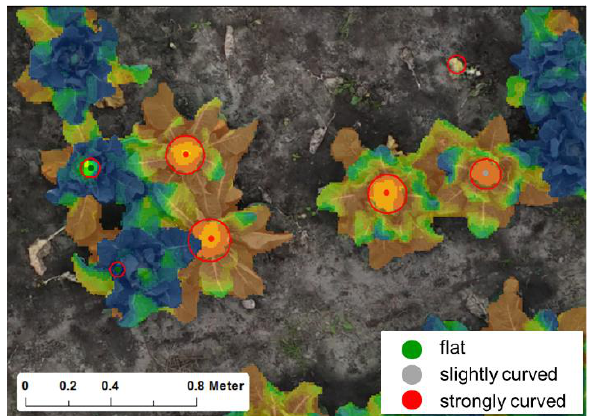
Figure 7: Example of cauliflower plants with automatically detected head diameter, curvature of the head and the stature height